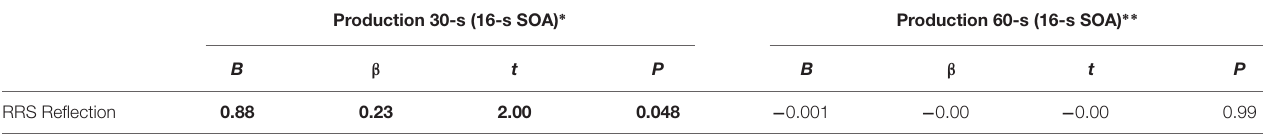
TABLE 7 | Multiple linear regression analysis between production tasks (16-s SOA conditions) and significant psychological